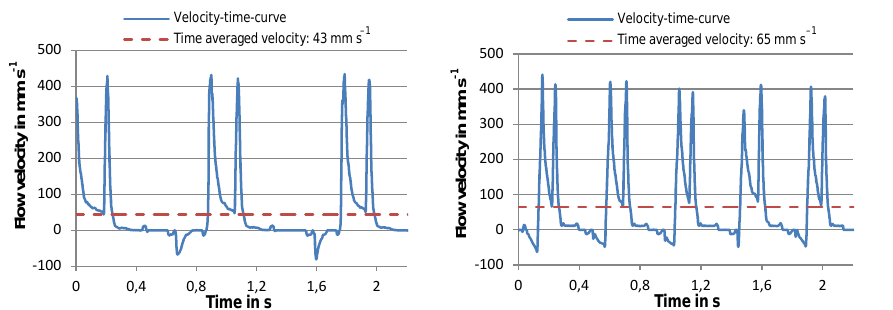
Figure 3. Velocity–time curve measured at the outlet of the oxygenator for different pumping frequencies (left: 1.2Hz, right: 2.4Hz).